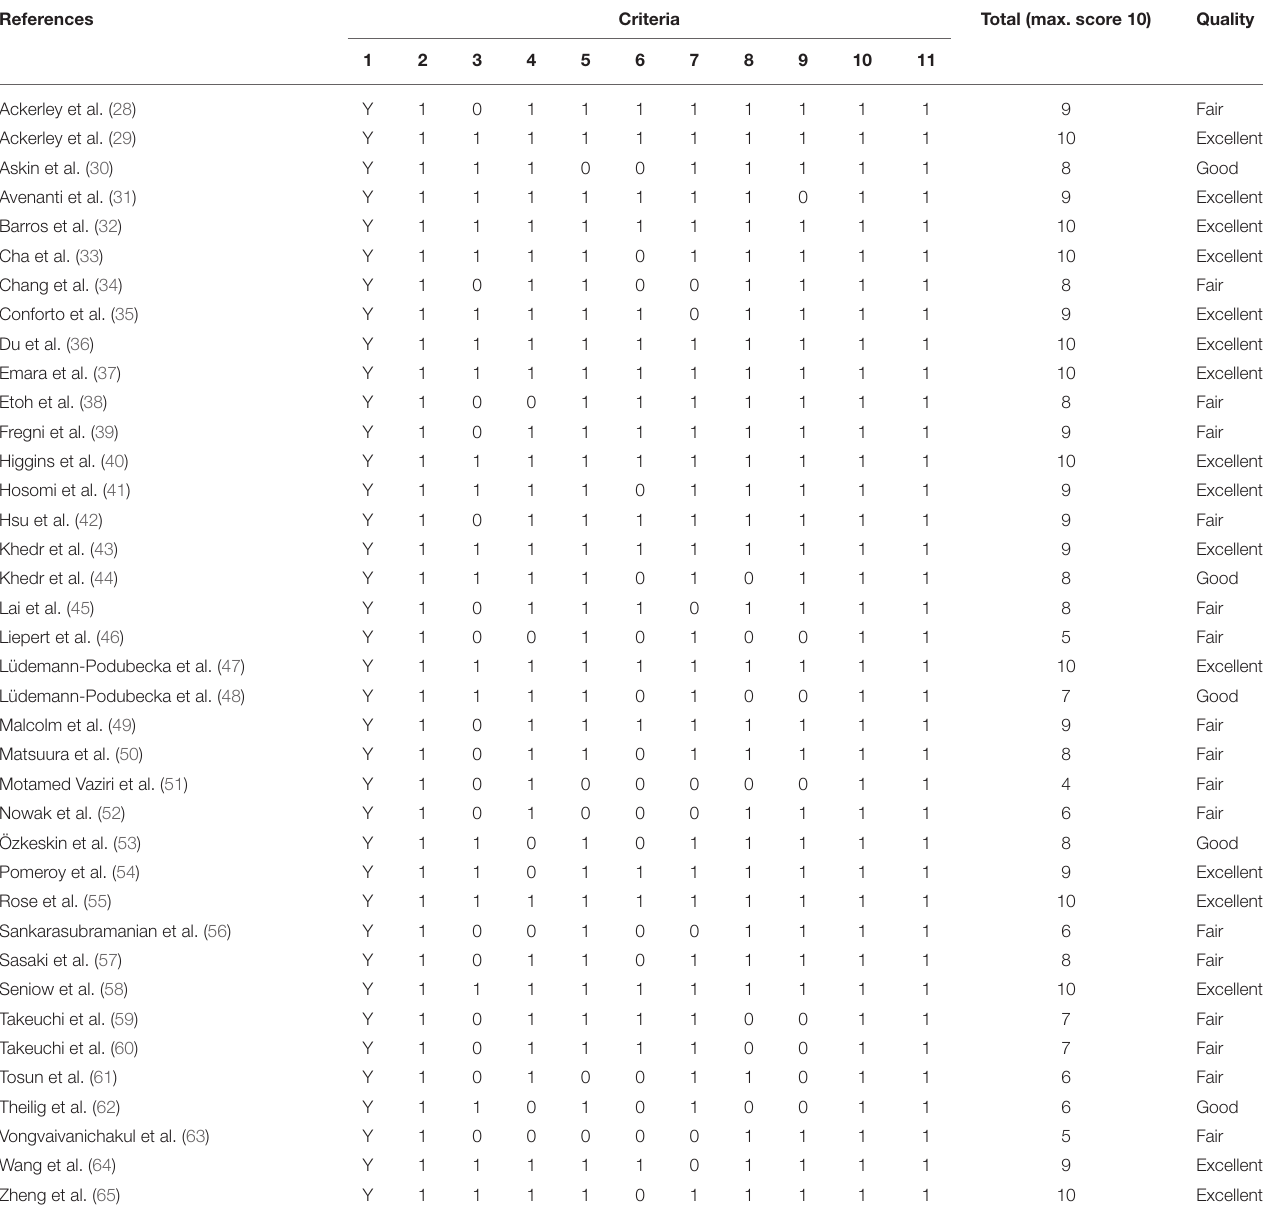
TABLE 2 | Assessment of risk of bias of the included